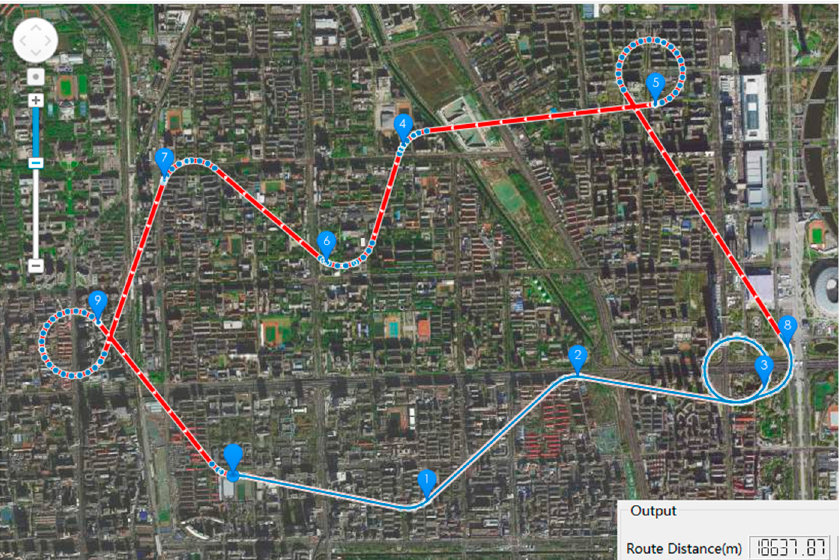
Figure 14. Schematic diagram of the simulation results of the multi-mission-point route planning method based on DUBINS curve. The red line with arrows is the calculated best route, and the blue line is the route that the simulated airship has traveled. And the output shows that the total route distance of the optimal route is 18,637.87 m. Table 2. Comparison of simulation results of two route planning methods.